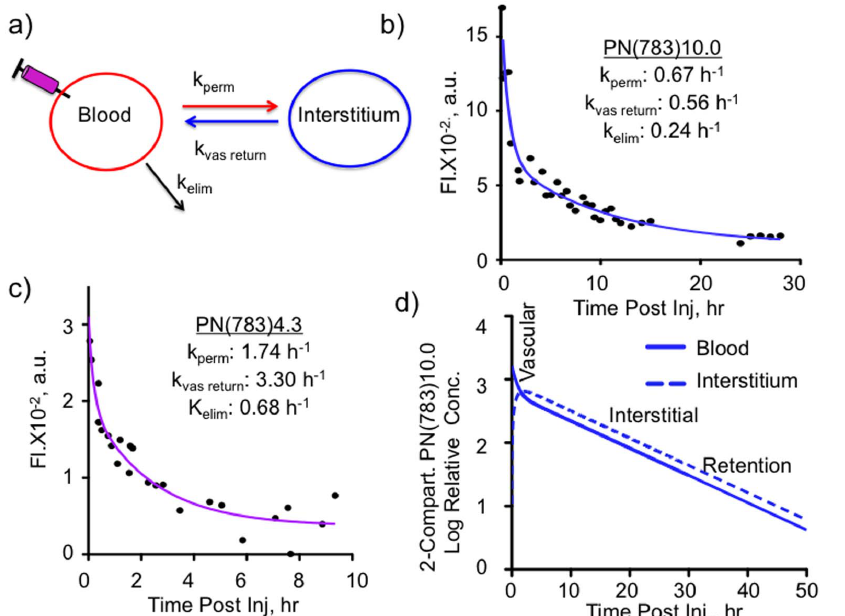
Figure 4. Variable PN pharmacokinetics analyzed by the two compartment pharmacokinetic model in normal mice. A ) Two compartment pharmacokinetic model showing three microscopic rate constants. Serum fluorescence for PN(783)10.0 B ) and PN(783)4.3 C ) after injection are shown. Data were fit to the two compartment model with data provided in Table 1. D) Time courses for blood and interstitial fluorescence of PN(783)10.0 using microkinetic constants from B ).